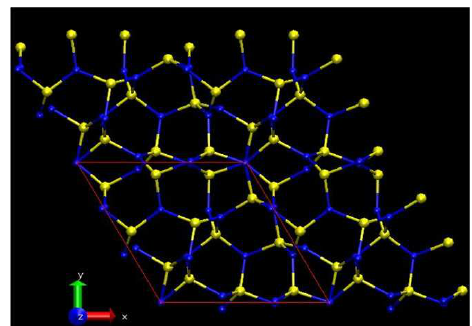
Fig. 1. Structure of Si 3 N 4 crystalline α phase